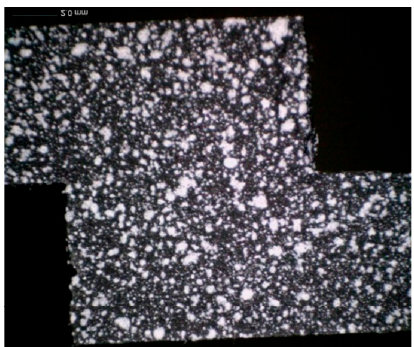
Figure 3. Example of the images of the side of the specimen used to perform the image correlation. Later, the digital image correlation was performed with DICe open-source software [31], with the aim of recognizing the onset of the crack. An example of the results of the correlation of a fatigue test is given in Figure 4 (peel strain) and Figure 5 (shear strain). Four images are given: (a) at the beginning of the test, (b) last acquisition before the crack onset, (c) first acquisition after crack onset, and d) last acquisition before failure. It can be noticed that for a number of cycles equal to 209,000, just before the final failure (panel d), the presence of the defect is clearly noticeable for both the strain fields. Panels b and c of Figure 4 and Figure 5 show the two strain distributions at the photogram just before and after the onset of the defect. It can be noticed that the presence of a small defect is more evident when the peel strain is analyzed, while it is difficult to locate it by analyzing the shear strain. Therefore, the first strain field was used to identify the onset and the corresponding number of cycles. The crack was considered to be initiated when a small defect (0.1–0.2 mm) could be detected from the result of the correlation.